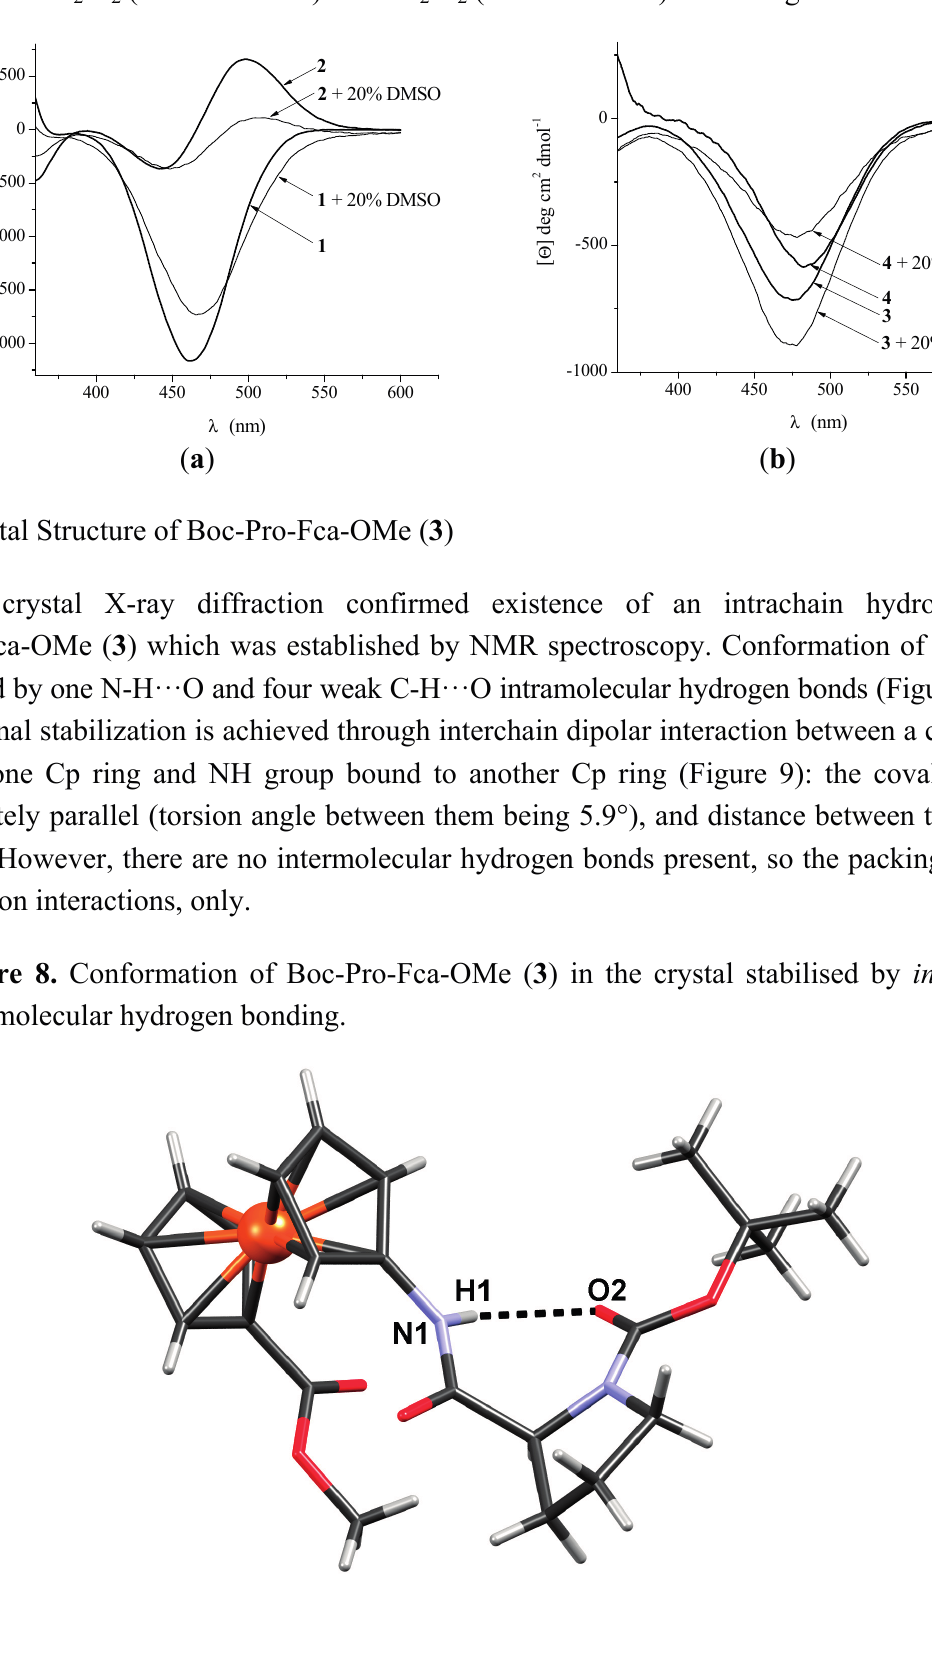
Cl ( c = 5 × 10 − 3 M) containing 20% of DMSO. 2 2